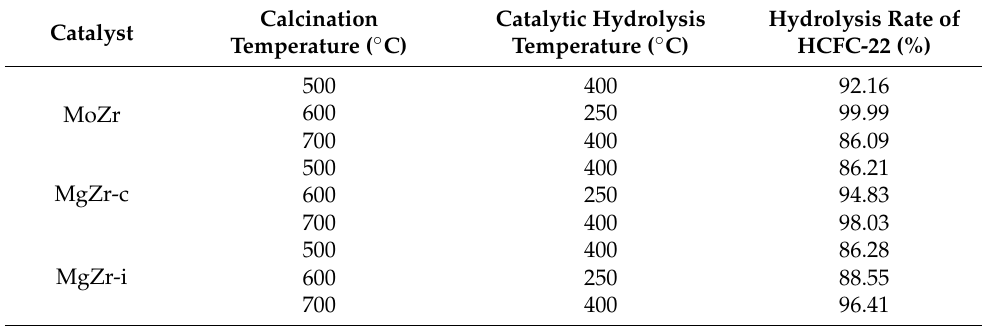
Table 5. Catalytic performance of solid acid MoO 3 /ZrO 2 and solid base MgO/ZrO 2